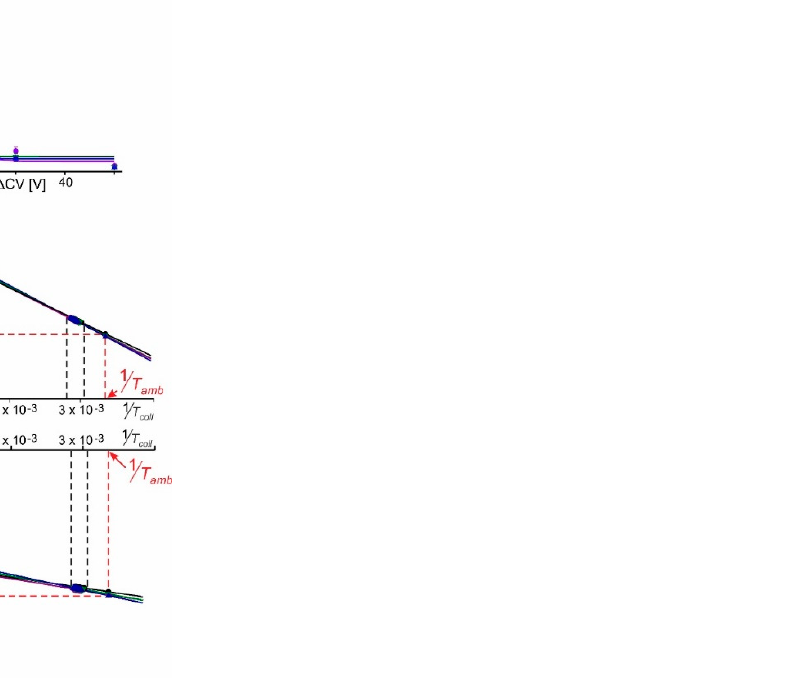
Figure 3. Nano-ESI mass spectra of RNAse S dissociation reactions. Collision cell voltage differences ( ∆𝐶𝑉 ): ( A ): 3 V. ( B ): 11 V. ( C ): 30 V. ( D ): 50 V. Charge states and m / z values for selected ion signals are given. RNAse S ions (reddish circles with dots), S-protein ions (reddish circles without dots), and released S-peptide ions (reddish dots) each represent the two major molecular species (red: low molecular weight species; purple: high molecular weight species). Solvent: 200 mM ammonium ac- etate/methanol (90:10, v / v ), pH 7.